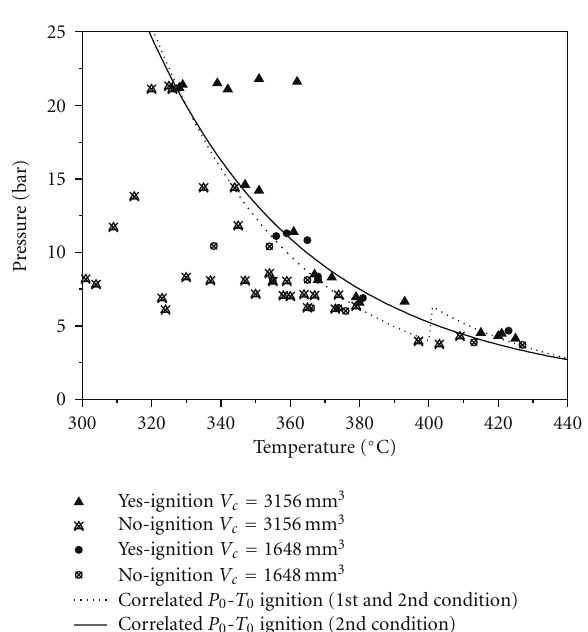
Figure 13: Pressure-temperature autoignition behaviour of Jet A- 1/O 2 /H 2 O.